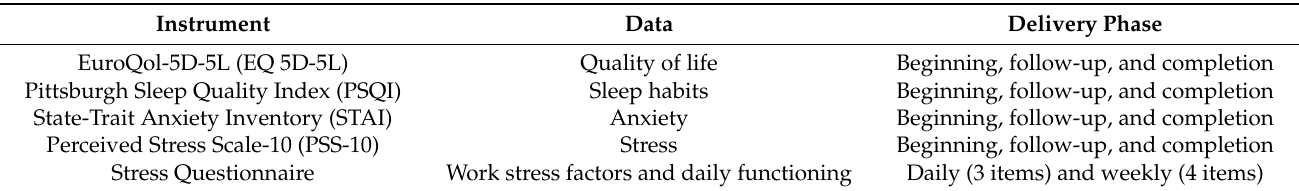
Table 1. Measuring assessment